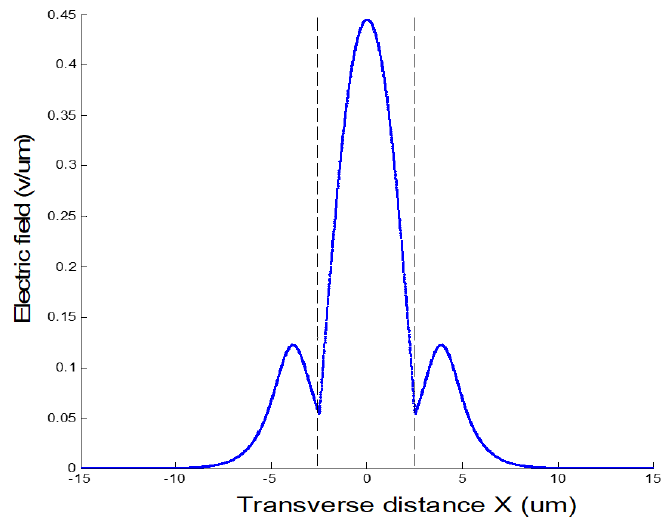
Figure 10. The electric field distribution with d f = 5 μ m and β = 1.5643.